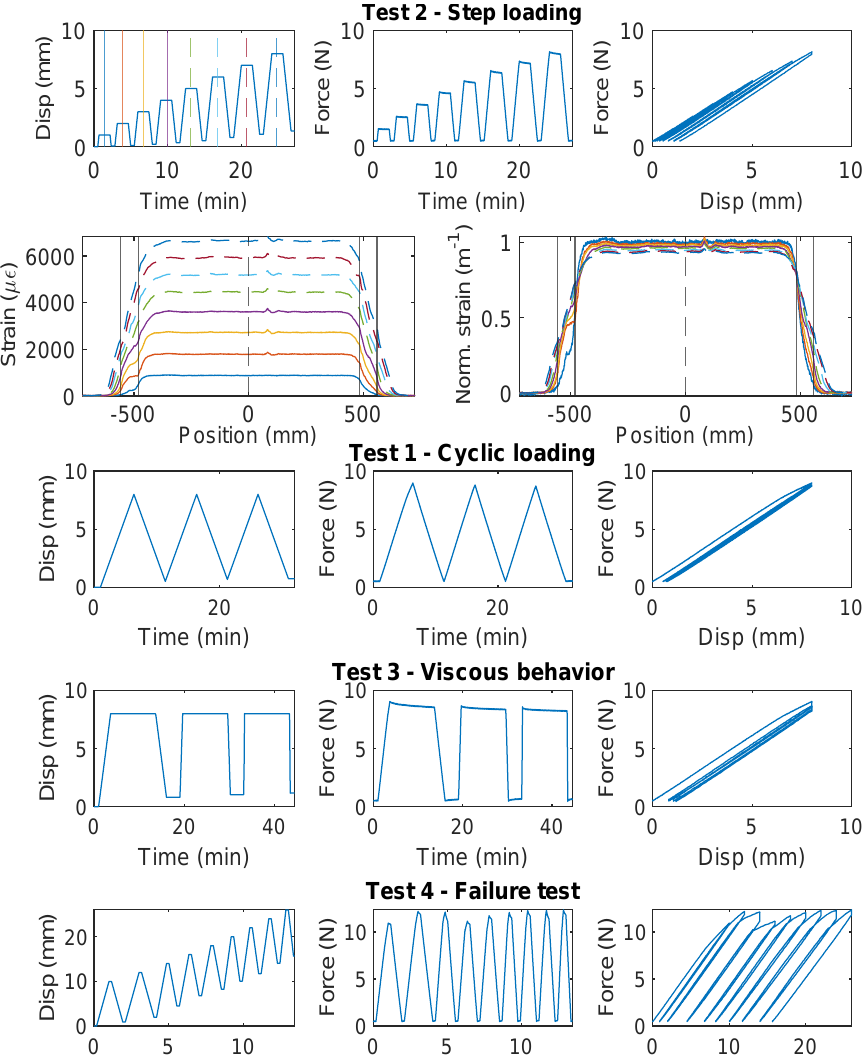
Figure 8. The loading protocol, force–displacement relation and strain distributions under increasing displacement levels (represented by different color lines) for Specimen 3 of the PFA-Silicone 0.9 mm